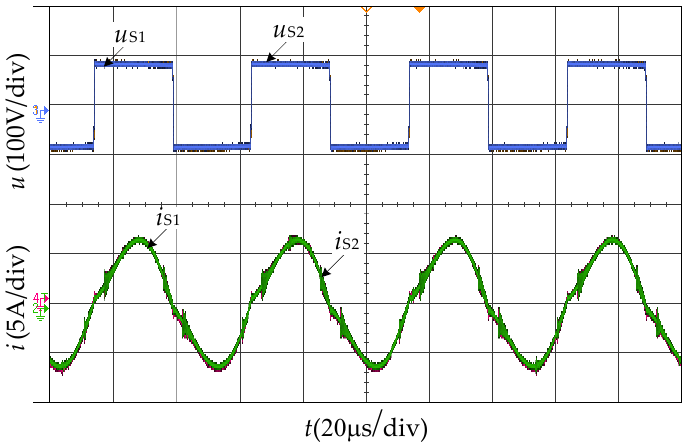
Figure 13. Input voltage and current waveforms of the receivers when the load is 10 Ω and δ equals 0.